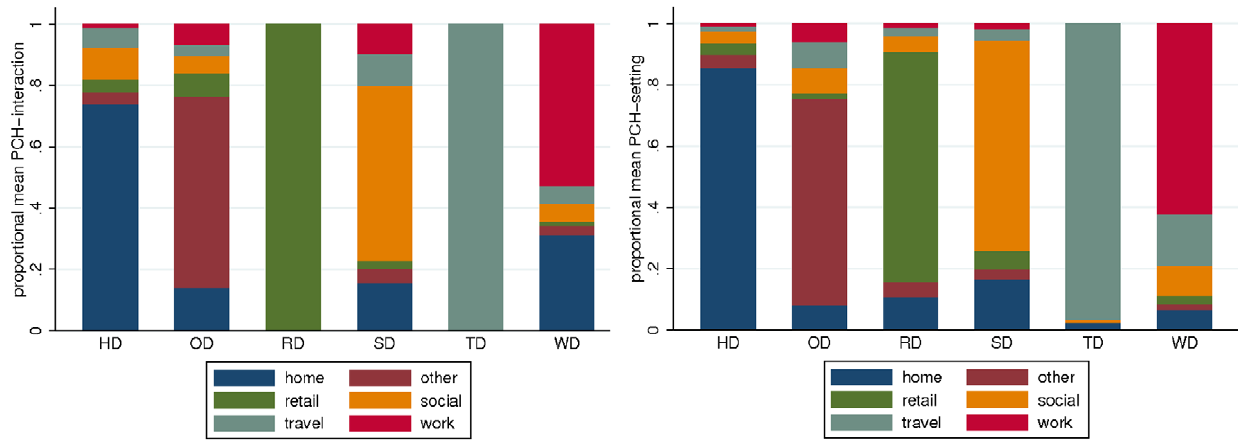
Figure 4. Cluster contact location profiles. Distribution of normalised PCH-interaction (left) and normalised PCH-setting (right) between each of the setting categories for the identified clusters. Clusters are named according to the setting which dominates the total daily PCH; home-dominated (HD), work-dominated (WD), social-dominated (SD), other-dominated (OD), retail-dominated (RD) and travel-dominated (TD).